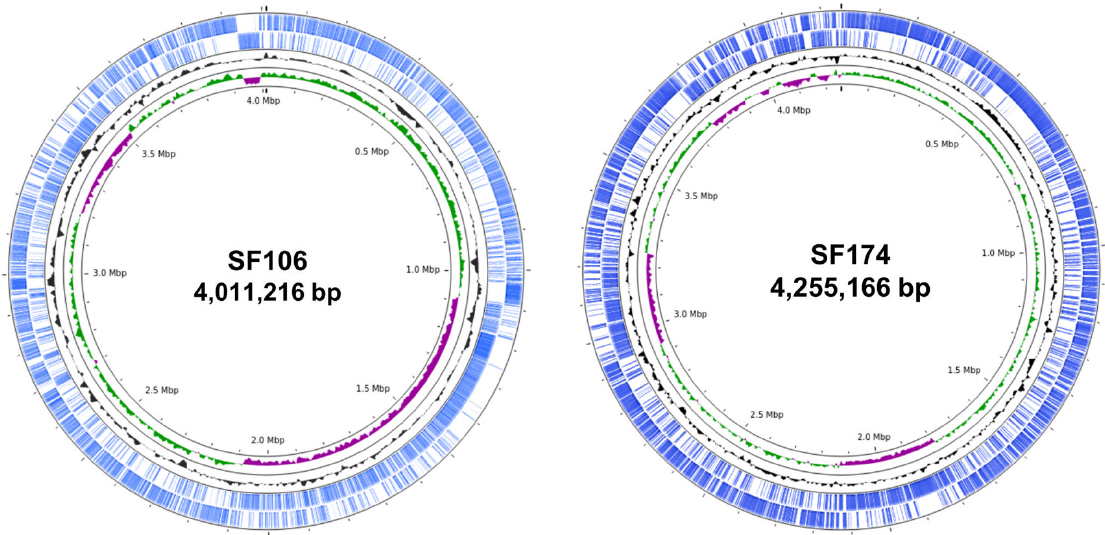
Figure 1. The circles represent from inside to outside: circle 1, DNA base position (bp); circle 2 and 3, GC content and GC skew; circle 4 protein-coding regions transcribed on the plus strand (clockwise); circle 5, protein-coding regions transcribed on the minus strand (anticlockwise). The genome plots were generated using Proksee. Table 1. General features of the SF106 and SF174 genomes.